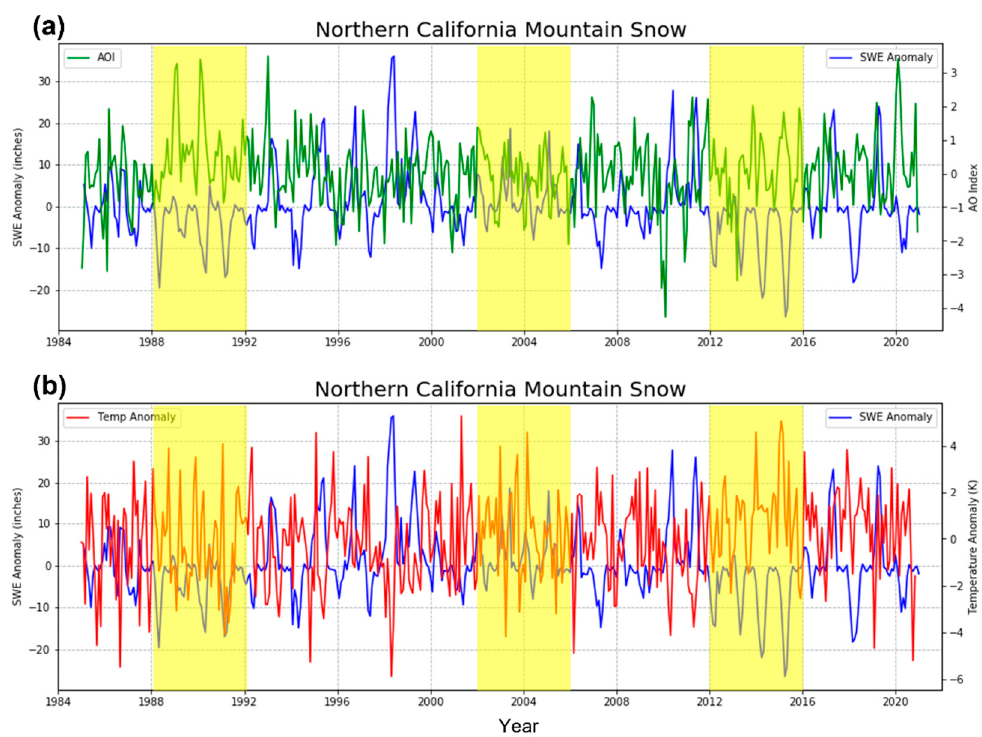
Figure 7. Time series of snow water equivalent (SWE) anomaly in the northern California mountain region (latitude max: 42°, latitude min: 36.8°; longitude max: − 120°, longitude min: − 124.2°) and the average of the four different sites across the region indicated in Figure 2b, ( a ) the 3-month average AO index and ( b ) 850 hPa air temperature anomaly from 1985 to 2020. The yellow shading refers to the three selective periods of 1988–1992, 2002–2006, and 2012–2016,